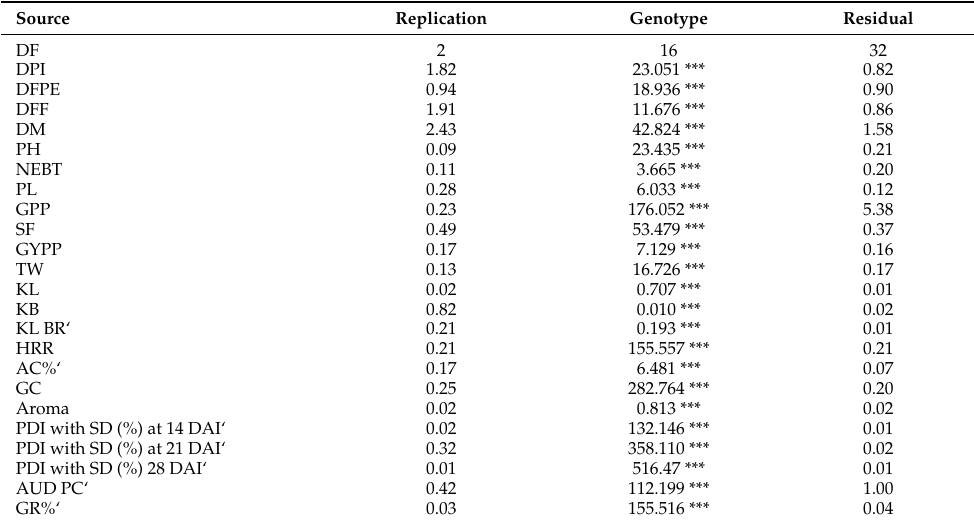
Table 5. ANOVA of parents and BC 2 F 3 and BC 2 F 4 (pooled) derivatives of HUR 917/IRBB66 for morpho-agronomical traits. Source